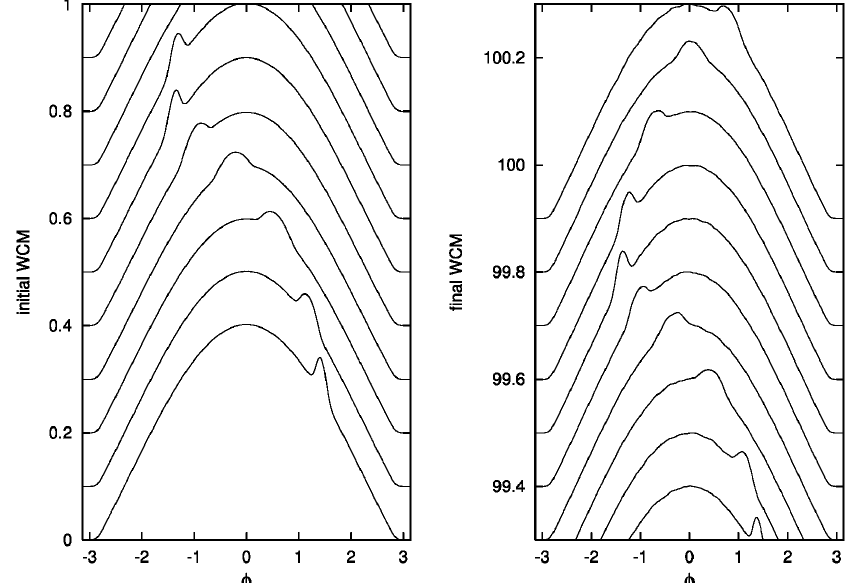
FIG. 16. Simulated wall current monitor data for a soliton with fractional charge = (cid:1) 0 : 01 . The parameters of the hump were (cid:1) 1 , a (cid:1) 0 : 1 , and b (cid:1) 0 : 2 . The intensity parameter was ‘ (cid:1) 0 : 07 . The plot on the left shows the evolution for the first A 0 synchrotron oscillation and the plot on the right shows the evolution over the last of 100 synchrotron oscillations. There are 9 (cid:18) 10 5 macroparticles of varying charge and the smoothing length for the coherent force calculation is 1 = 50 th of the bunch